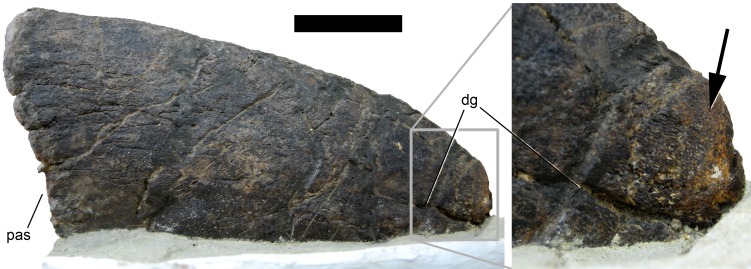
Possible preservation of keratinous sheet on left manual ungual I-2 of Galeamopus pabsti SMA 0011 (medial view).Note the different surface texture at the tip (arrow), compared to more posterior portions. Abb.: dg, distal groove; pas, proximal articular surface. Scale bar = 5 cm.